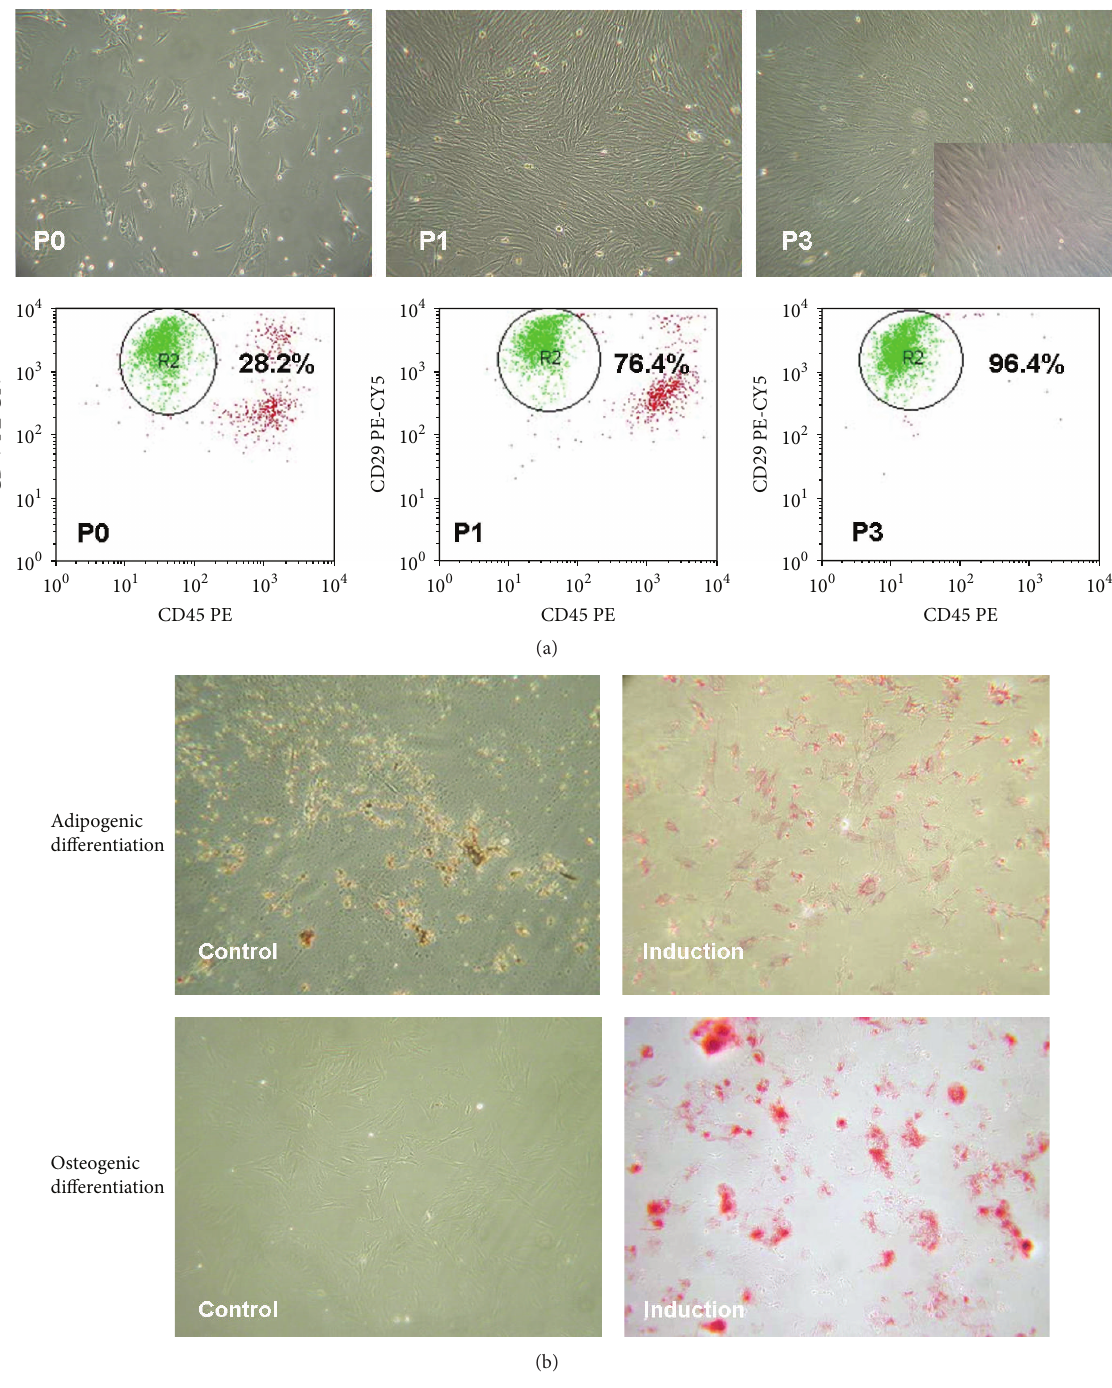
Figure 2: (a) Typical cell shapes in primary culture, the adherent MSCs were triangular and fusiform and other cell shapes were also present ( × 200). P1 MSCs showed a fibroblast-like shape and whirlpool-like distribution ( × 100). Whirlpool-like distribution of the third passage of MSCs ( × 100). Embedded image shows P3 MSCs observed under phase contrast microscopy ( × 400). Flow cytometric analyses of CD29 + CD44 + CD45 − cells in MSCs at P0, P1, and P3; the percentage of Lin-CD29 + CD44 + CD45 − cells gated in R2 was 28.2%, 76.4%, and 96.4%, respectively. (b) Negative Oil Red O staining of control group MSCs at P3 MSCs were cultured in common medium before staining ( × 100). Positive Oil Red O staining of MSCs at P3 after 5 days of adipose differentiation induction; fat drops in MSCs are stained red ( × 100) in Negative Alizarin Red S staining of control group MSCs at P3; MSCs were cultured in common medium before staining ( × 100). Positive Alizarin Red S staining of MSCs at P3 after 14 days of osteocyte differentiation induction, calcium deposition in MSCs stained red ( ×